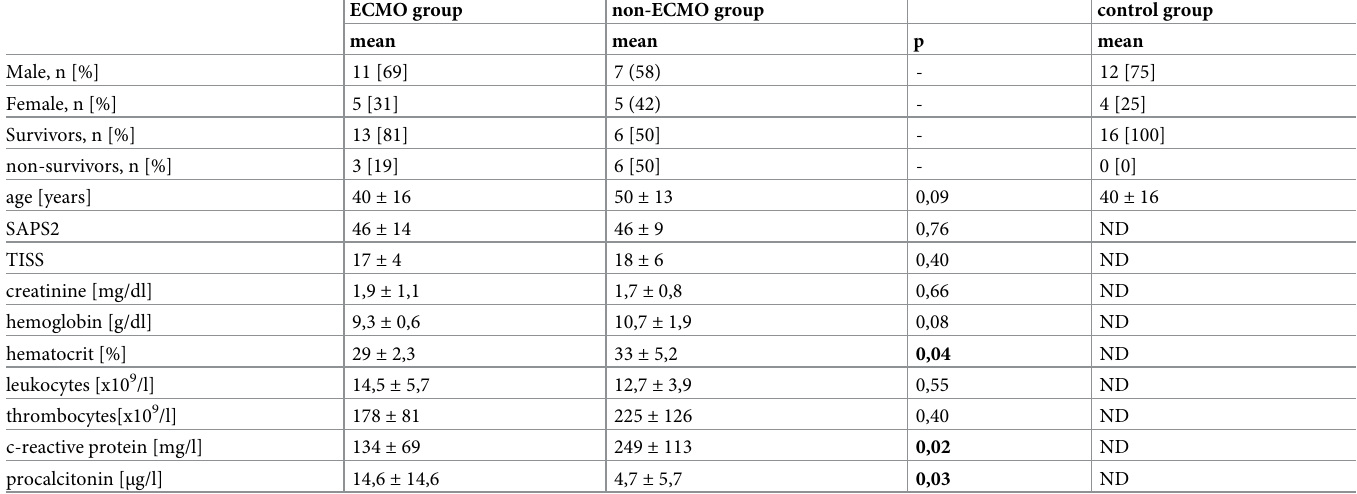
Table 1. Characteristics and laboratory findings in all study subjects.